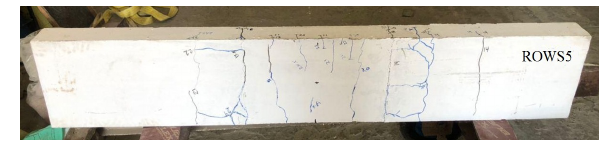
Figure 18: Bottom crack pattern of slab ROWS5.